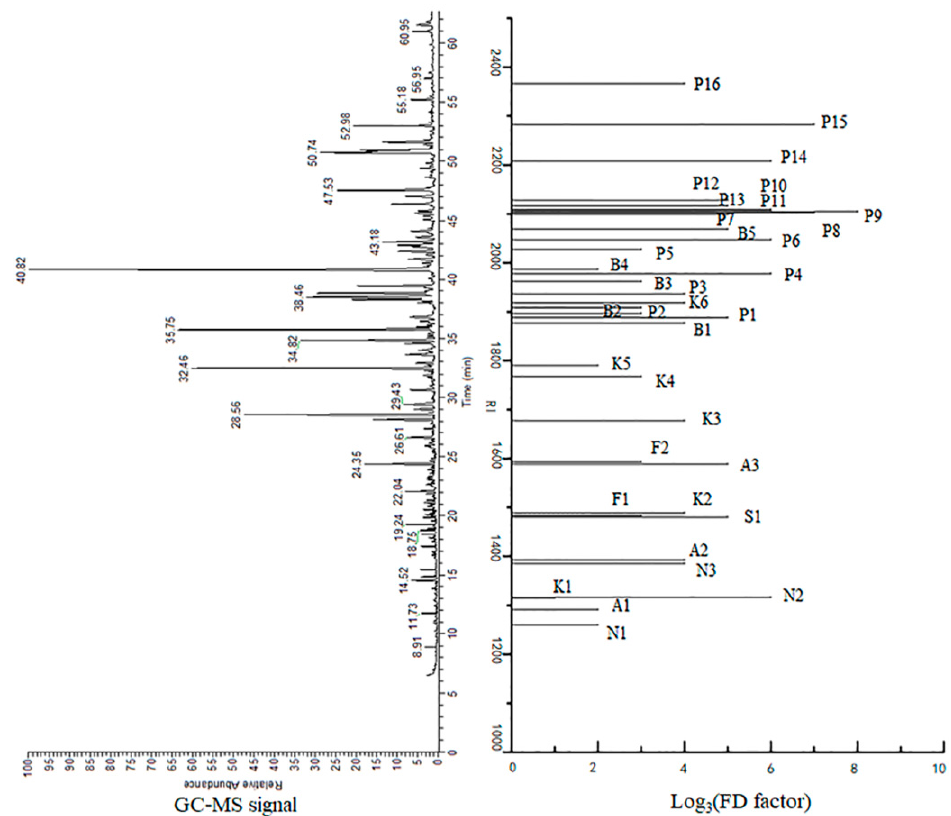
Figure 3. Aromagram and chromatogram of the volatiles isolated from traditional Hunan smoke-cured pork leg (THSL) with their flavor dilution (FD) factors and retention indexes (RIs) on a TG-WAX column according to Table 2.